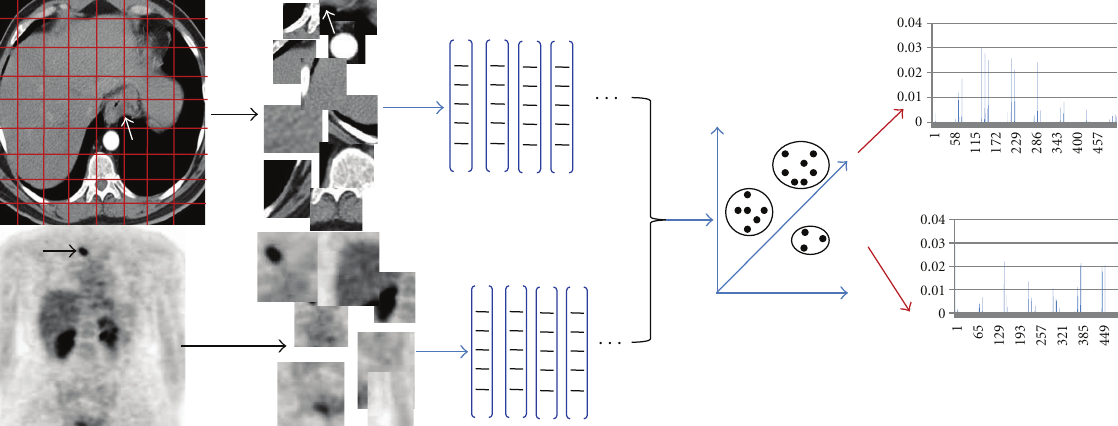
Figure 1: BOW feature extraction procedure.